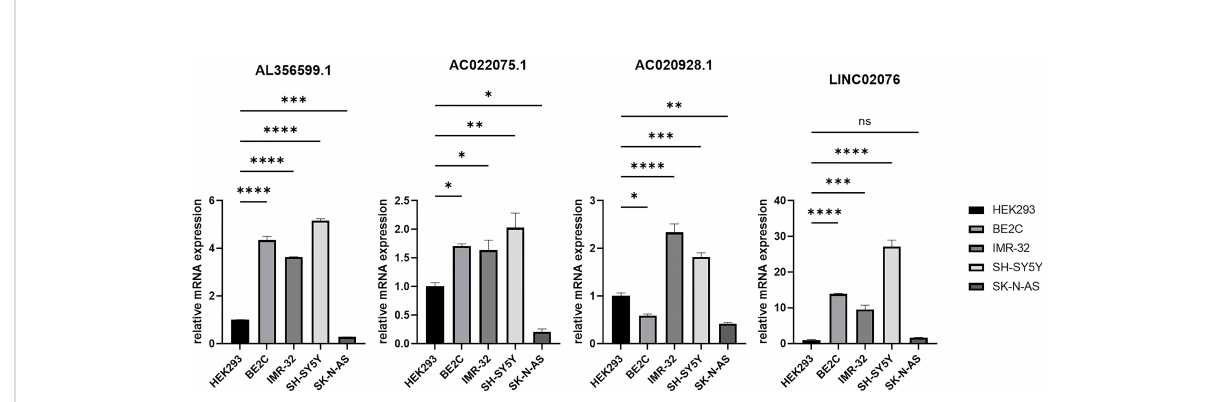
FIGURE 9 The expression of autophagy-related four-lncRNA in wild type cell lines. Results are representative of three independent experiments, ns p > 0.05; * p < 0.05; ** p < 0.01; *** p < 0.001; **** p <